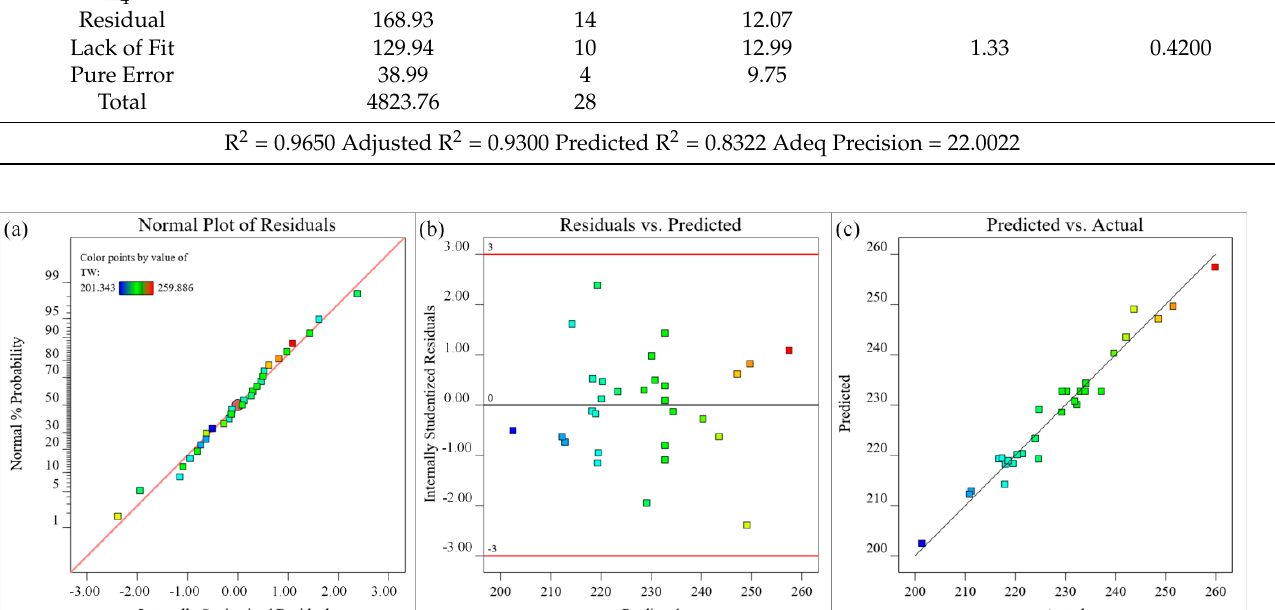
Table 10. ANOVA of the regression model for MRR.